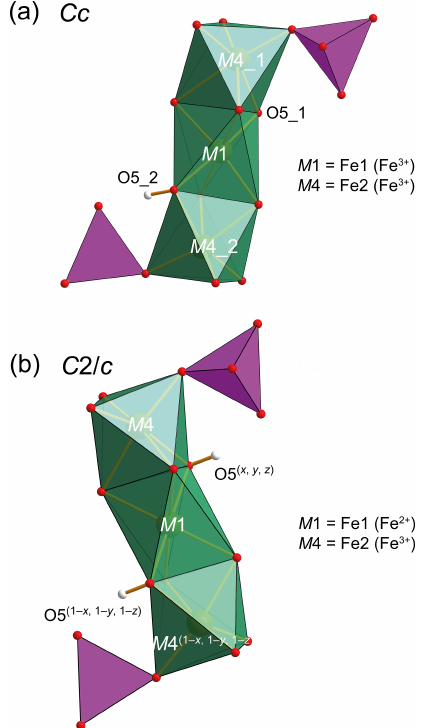
Figure 11. Octahedral trimers in beraunite (a) and ferroberau- nite (b) . Symmetry operations are given for the centrosymmetric structure. M 1 is occupied by Fe 3 + (beraunite) and Fe 2 + (ferrober- aunite). P tetrahedrons are purple and H atoms grey. H atoms in the case of the centrosymmetric structure have a reduced occupancy of